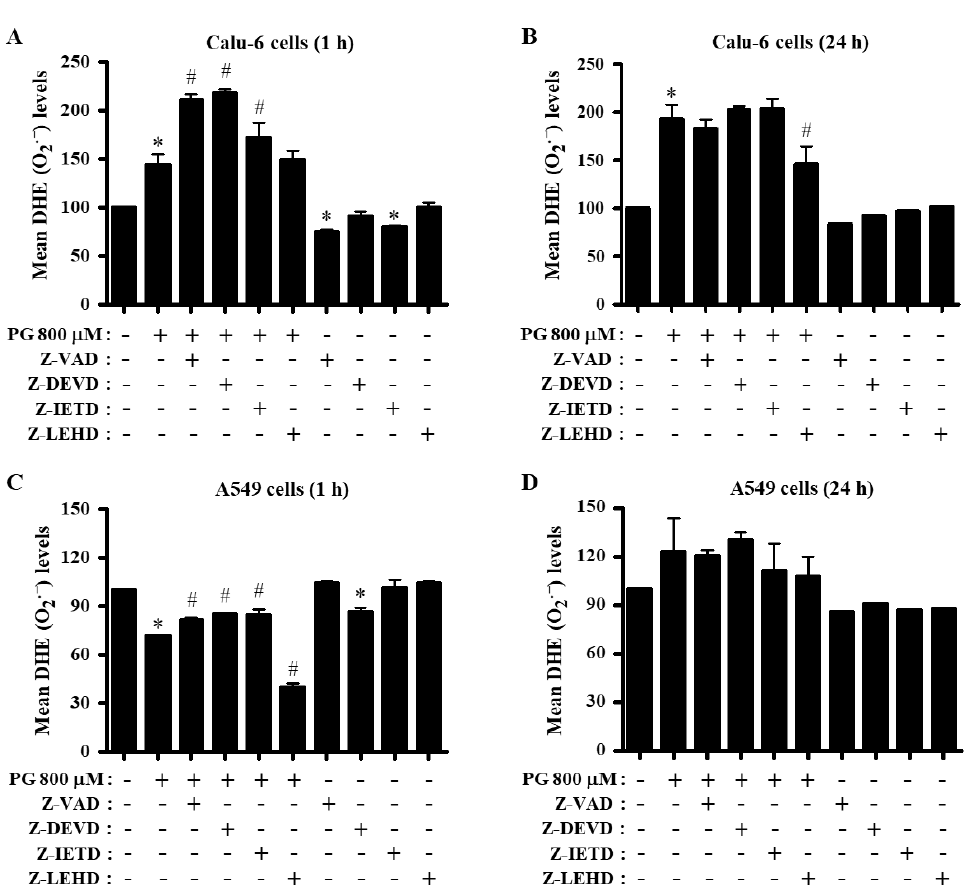
Figure 6. Effects of PG and caspase inhibitors on intracellular DHE (O 2 ·− ) levels in lung cancer cells. Exponentially growing cells were incubated with 800 µ M PG and/or each caspase inhibitor (15 µ M) for 1 or 24 h. DHE (O 2 ·− ) levels in lung cancer cells were measured using a FACStar flow cytometer. ( A , B ) Graphs indicate mean DHE (O 2 ·− ) levels (%) in Calu-6 cells at 1 h ( A ) or 24 h ( B ) compared with control cells. ( C , D ) Graphs indicate mean DHE (O 2 ·− ) levels (%) in A549 cells at 1 h ( C ) or 24 h ( D ) compared with control cells. * p < 0.05 compared with the PG-untreated control group. # p < 0.05 compared with cells treated with PG only.